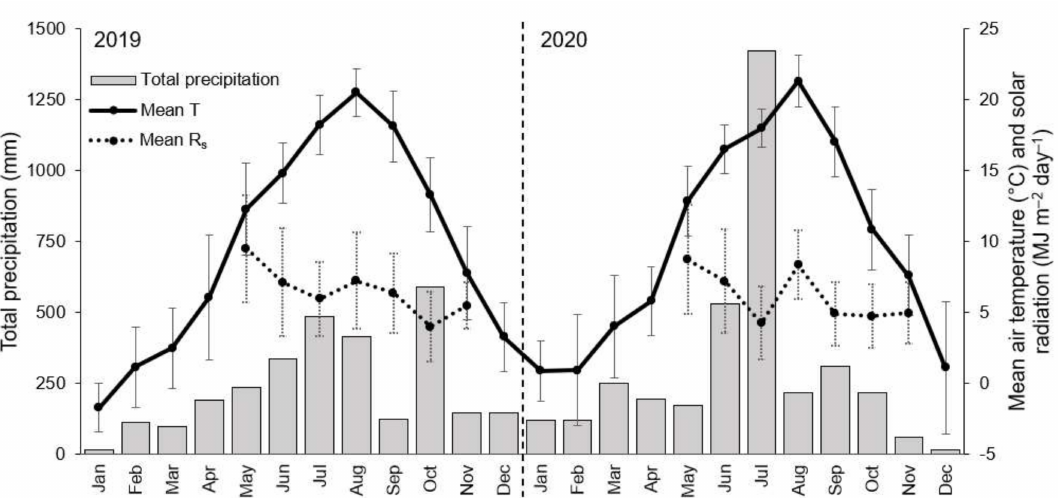
Figure A6. Monthly mean air temperature (T) and solar radiation (R s ), and monthly total precipitation in 2019 and 2020. Precipitation data were taken from the data of the Kawanehoncho meteorological station (the Japan Meteorological Agency, 2021). Error bars indicate the standard